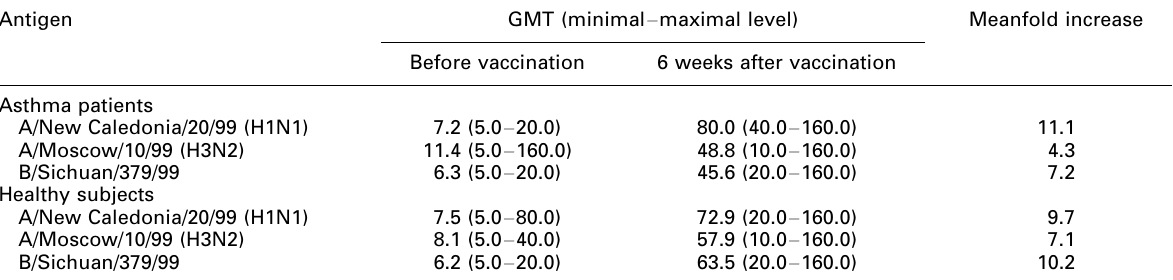
Table 2. Anti-neuraminidase antibodies titres before and after vaccinations against influenza in healthy subjects and patients with bronchial asthma Antigen